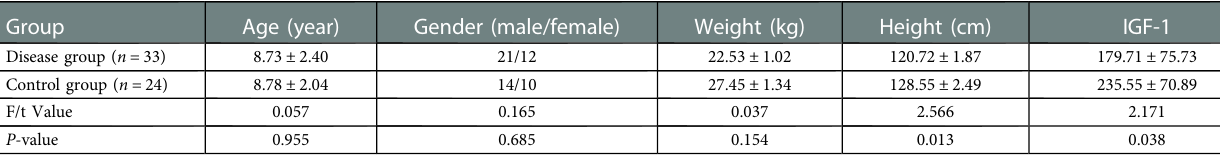
TABLE 1 Comparison of clinical information between children in the disease and control groups ( (cid:1) x + s ).